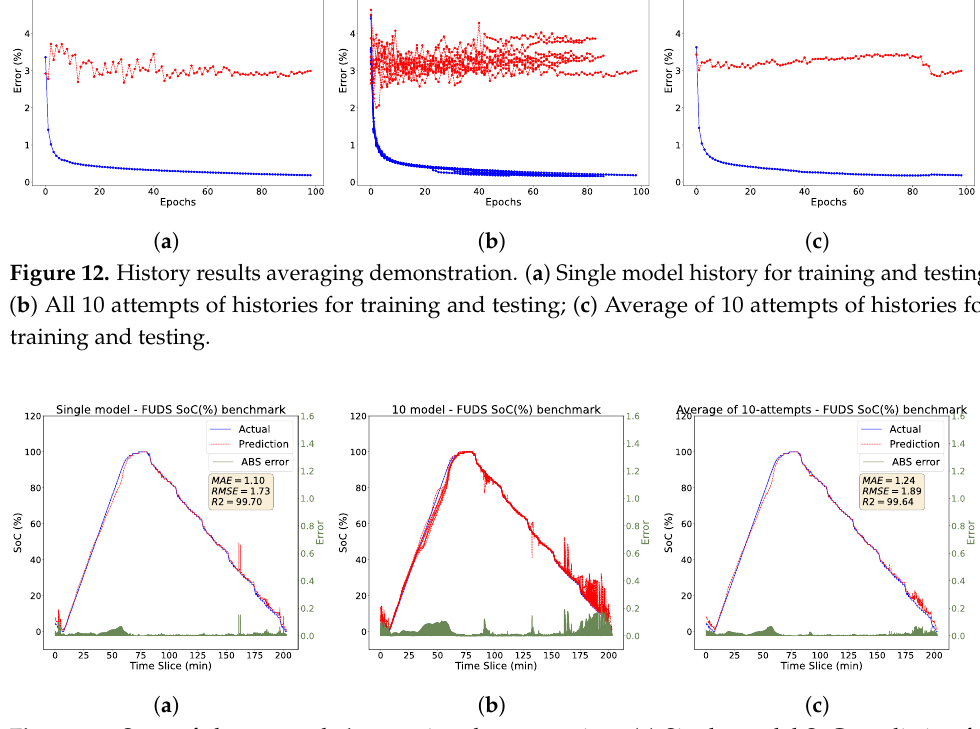
Figure 13. State of charge results’ averaging demonstration. ( a ) Single-model SoC prediction for training; ( b ) all 10 attempts a SoC prediction on a single plot; ( c ) average of 10 attempts at SoC prediction for